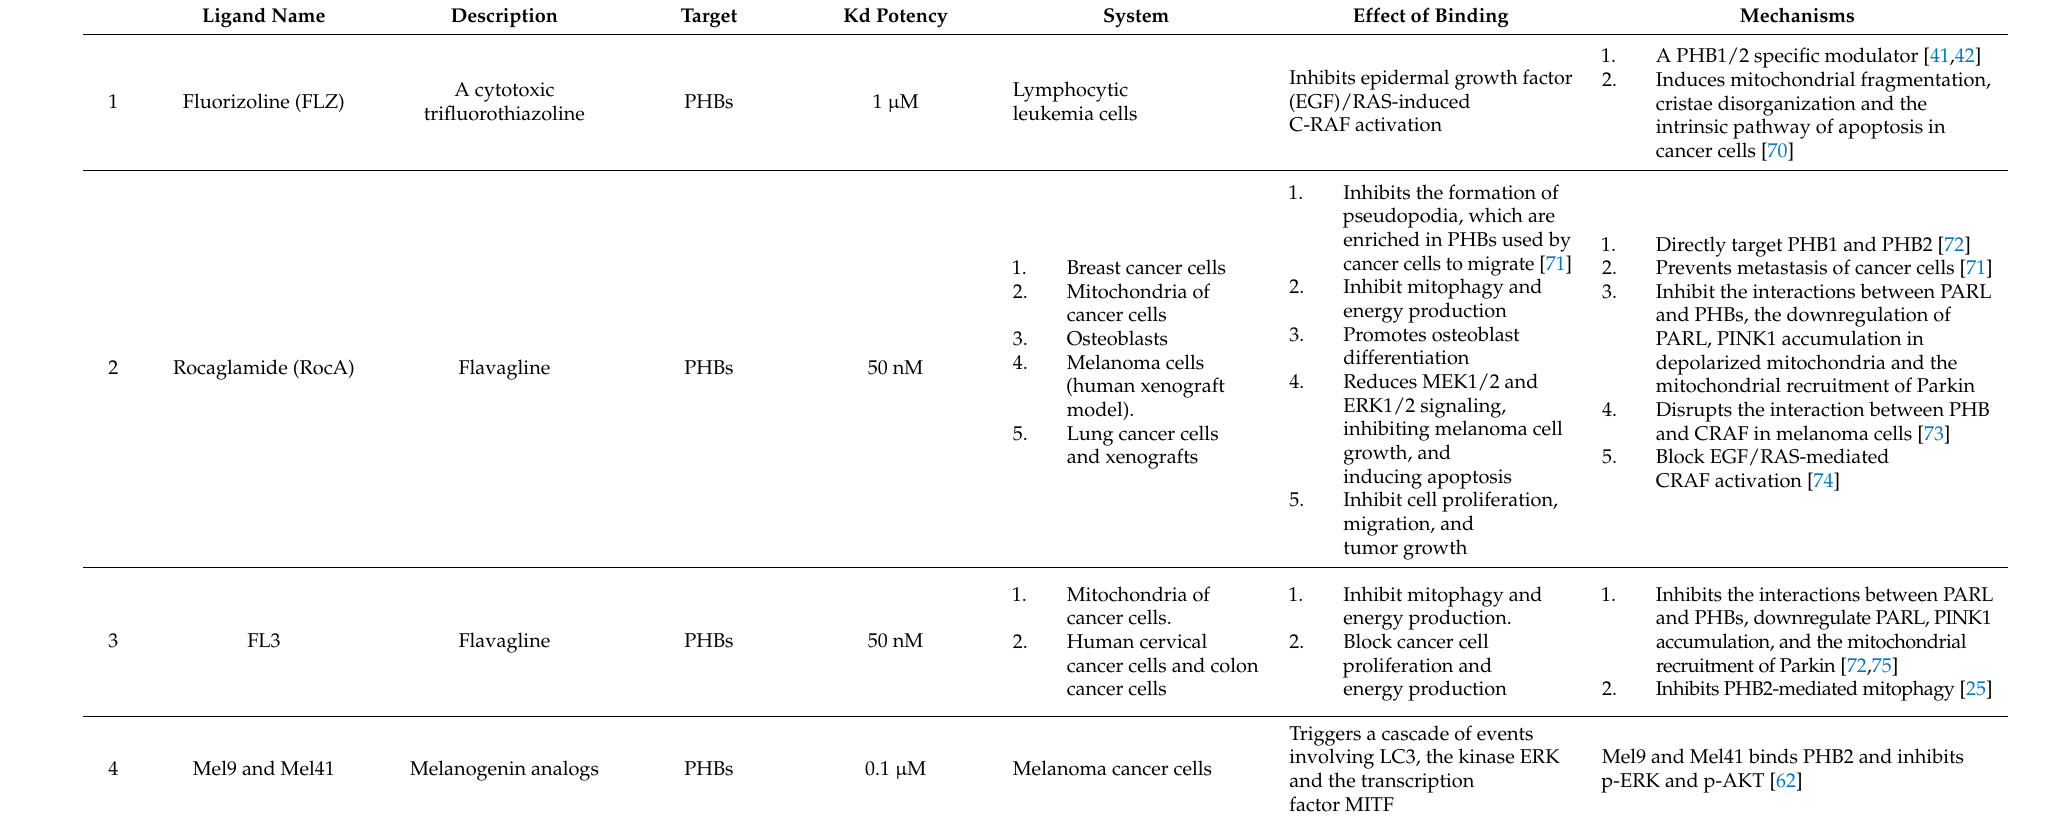
Table 2. The reported modulators for